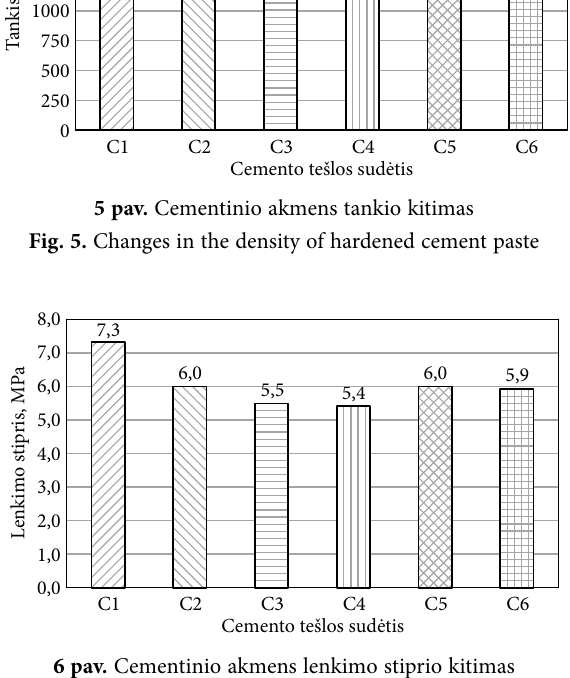
7 pav. Cementinio akmens gniuždymo stiprio kitimas Fig. 7. Changes in the compressing strength of hardened cement